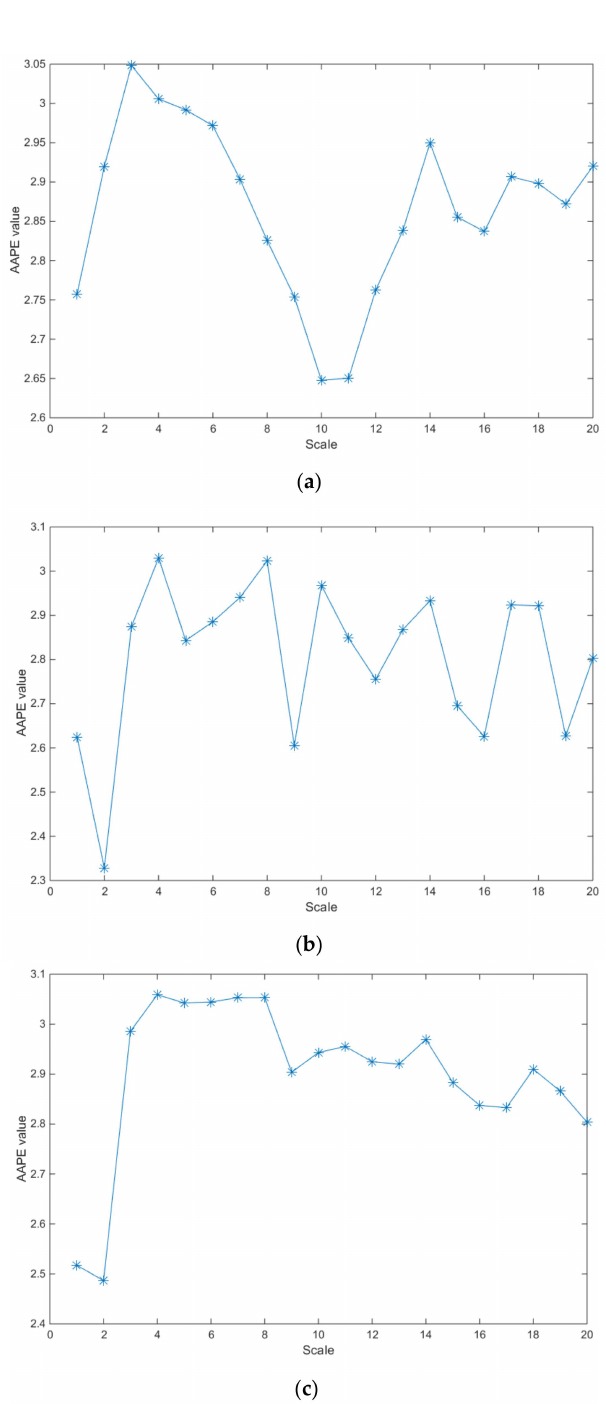
Figure 6. MAAPE feature values of rolling bearing vibration signal under di ff erent fault conditions with the same loads. ( a ) Inner race fault, 7 mils, with load 1 hp. ( b ) Outer race fault, 7 mils, with load 1 hp. ( c ) Ball elements fault, 7 mils, with load 1